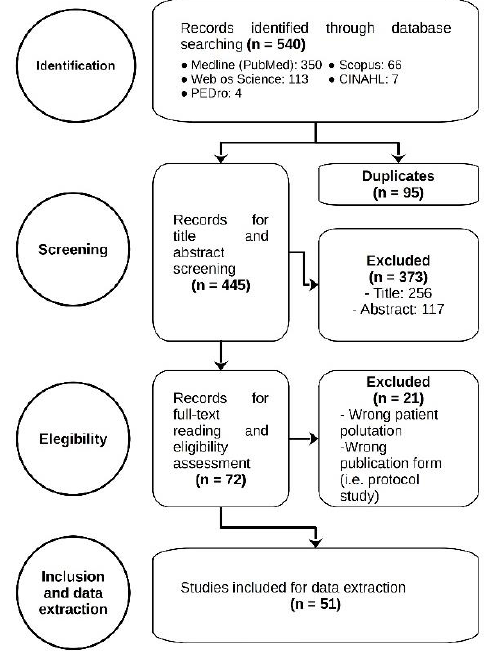
Figure 1. Flowchart diagram.